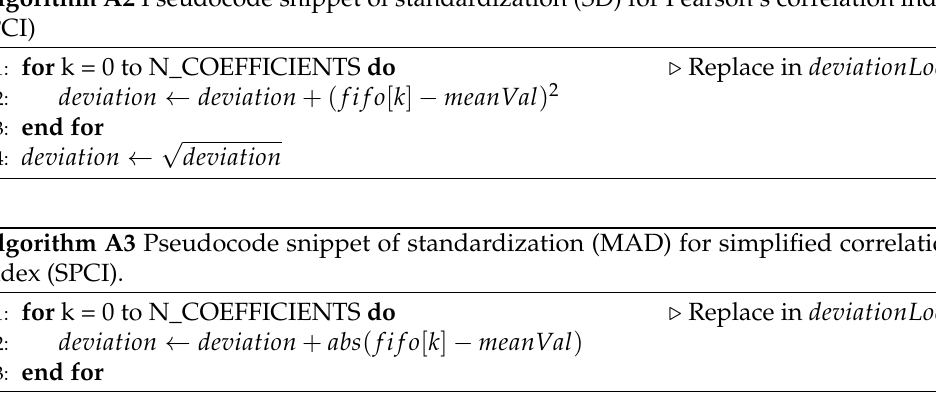
Algorithm A2 Pseudocode snippet of standardization (SD) for Pearson’s correlation index